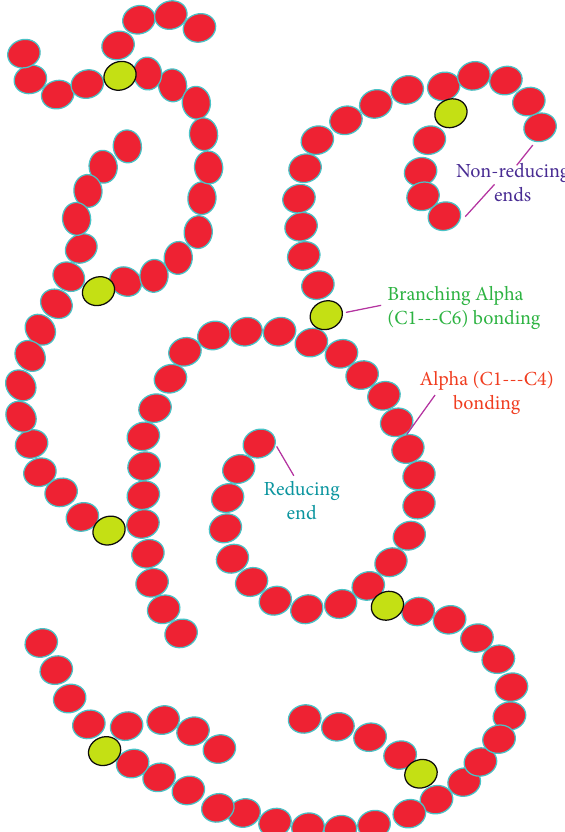
Figure 5: Abstract molecular structure of glycogen.